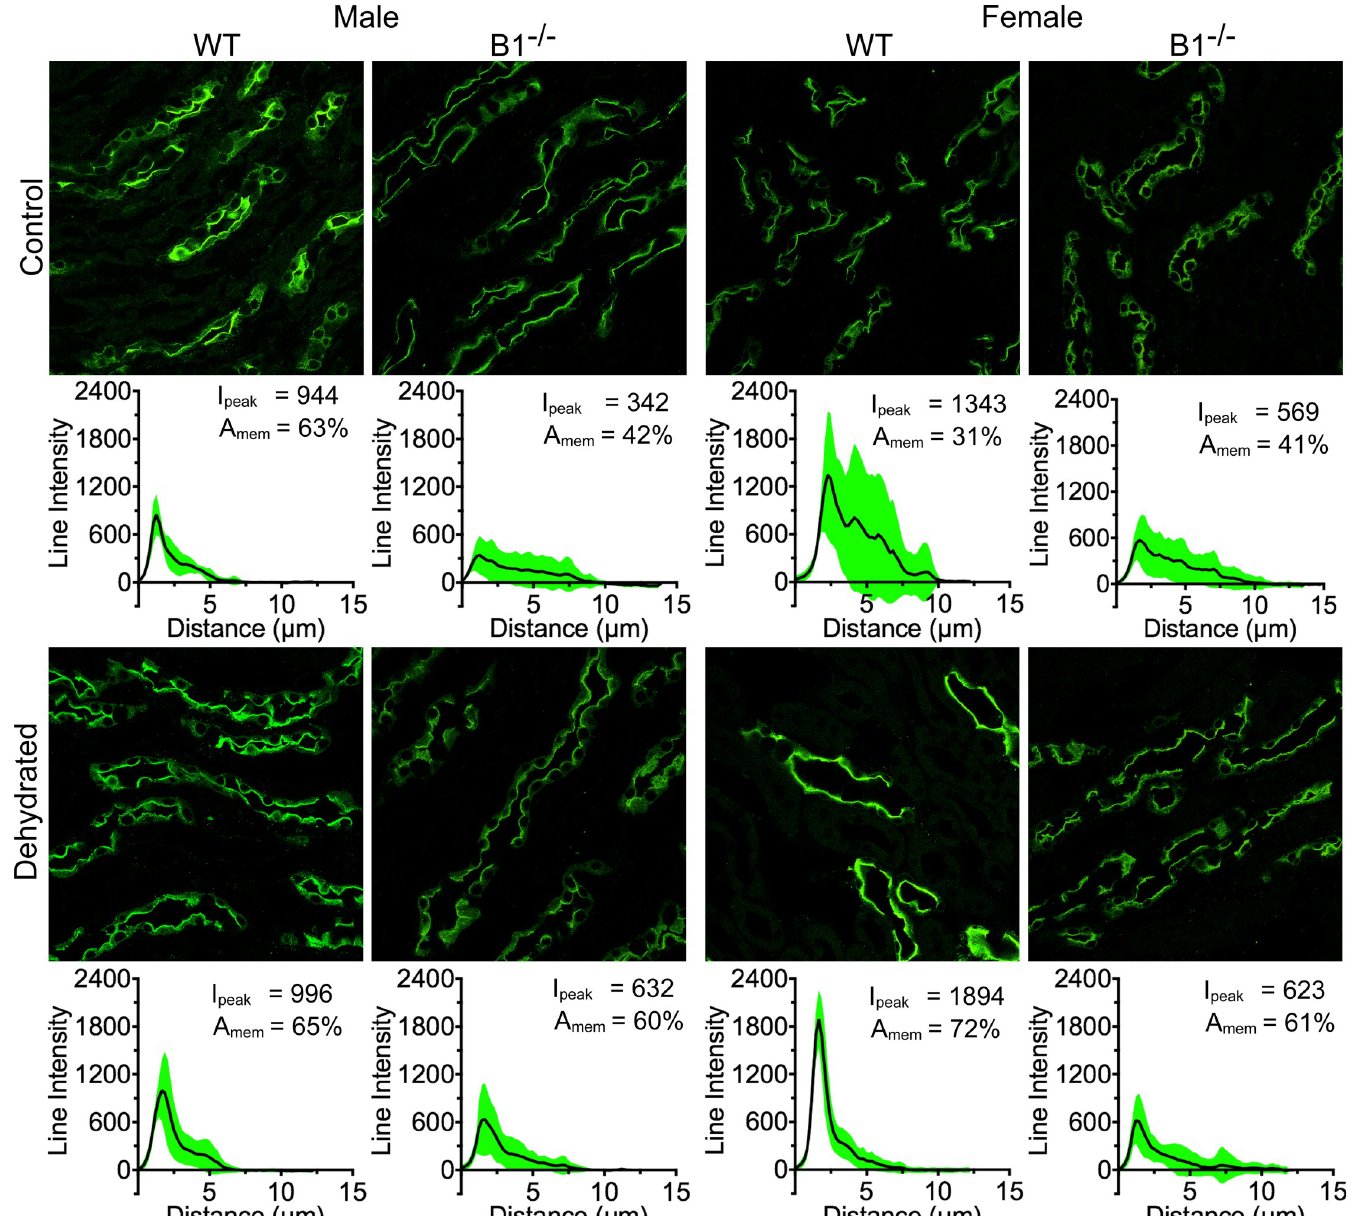
Fig 5. Female WT animals show the highest level of AQP2 regulation upon dehydration in the inner segment of the outer medulla. WT male animals do not show much regulation in this part of the kidney (2% increase in peak intensity and AQP2 in the membrane area, 1 st column), while Atp6v1b1-/- (B1 -/- ) males show a considerable amount of regulation with a 42% increase in AQP2 in the membrane region and an 84% increase in peak intensity (2 nd column). The highest amount of regulation was seen in the case of WT female animals with a 132% increase in the AQP dependent fluorescence in the membrane region and a 41% increase in peak intensity (3 rd column). Whereas female B1 -/- animals showed a mere 9% increase in peak intensity, there was a 48% increase in AQP presence in the membrane region (4 th